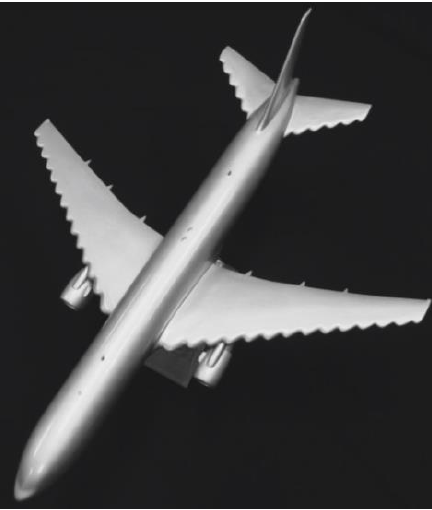
Figure 16. Tubercles on the leading edge of the wings and stabilizers of an aircraft [64].